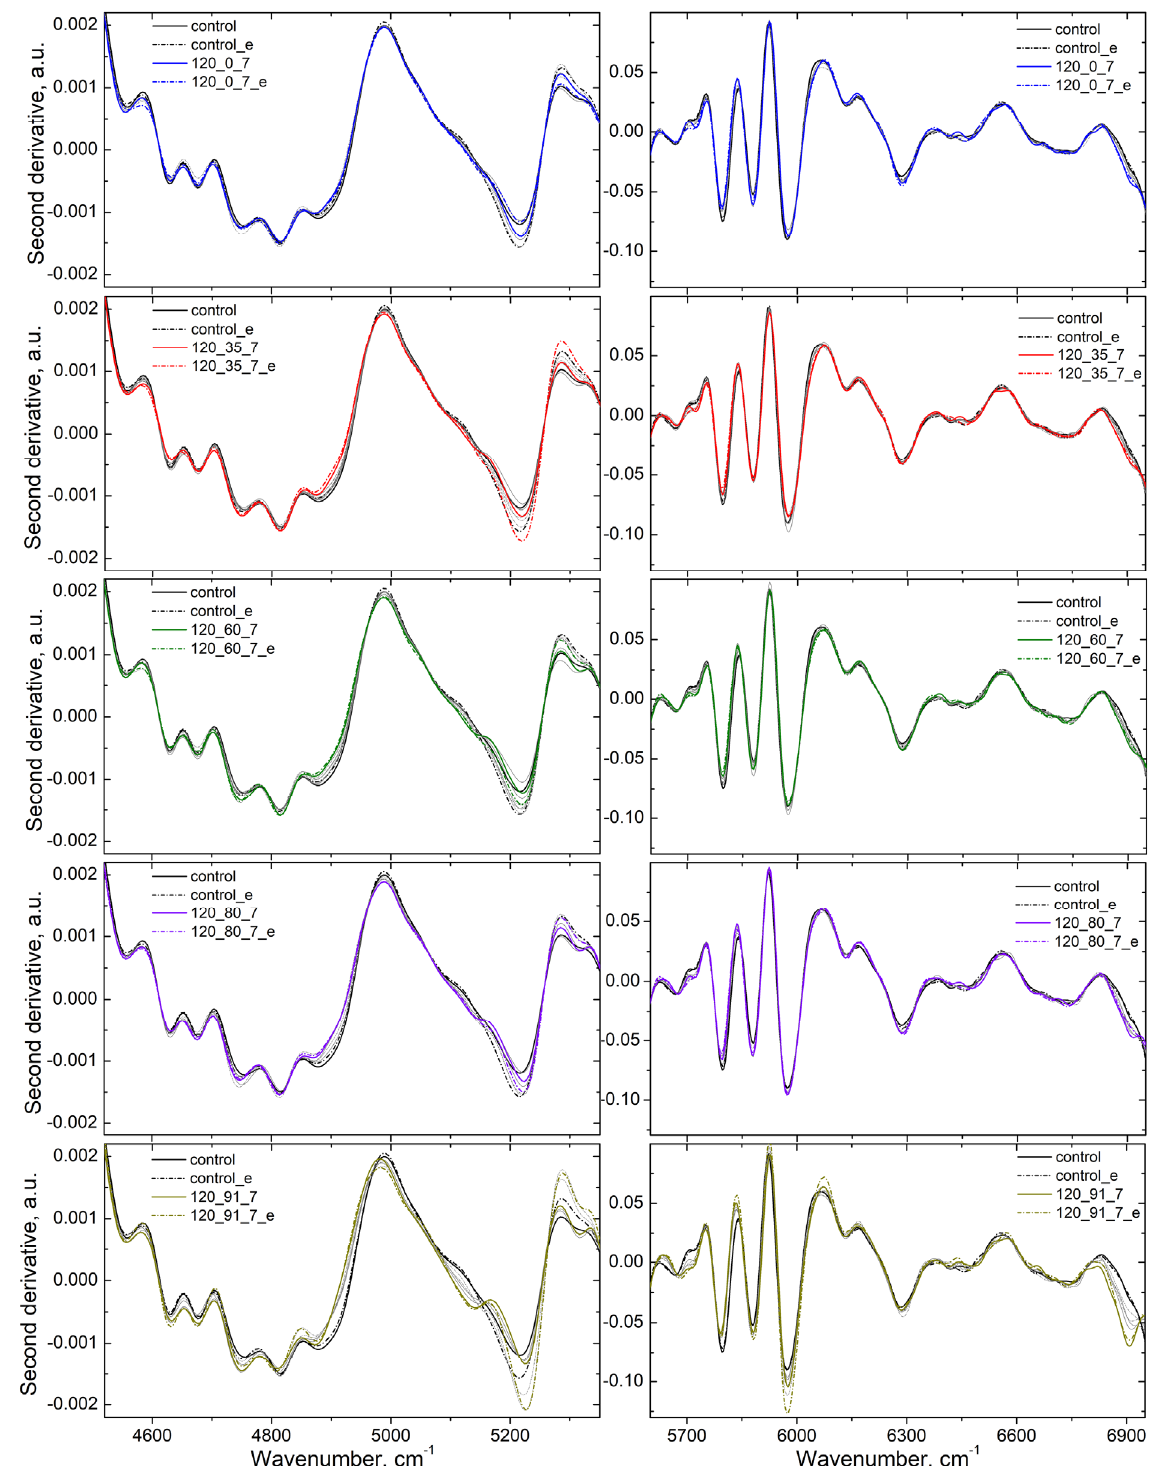
Figure 1. Second derivative of the NIR spectra in the 4520–5350 and 5600–6950 cm − 1 regions for control (black full line colour), hydro-thermal treated (coloured full line contours) and water-extracted (dotted line contours) spruce wood samples (T = 120 °C; RH = 0, 35, 60, 80, 91%; treatment time = 7 days; e—extracted). The spectral lines of the control and samples after the thermal treatment were highlighted, while the spectra of the samples with intermediary treatment time are represented with thinner grey lines. We kept the same colours for the extracted and non-extracted samples.